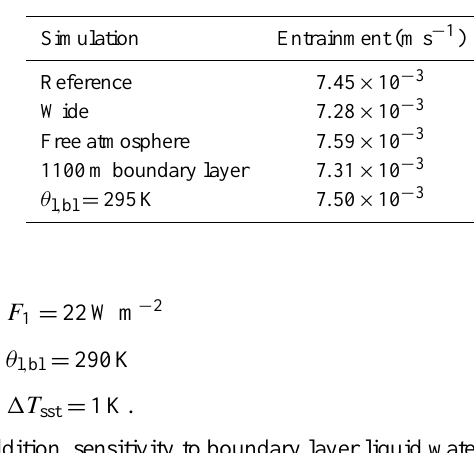
Table 2. The least squares fit of the rate of entrainment for different domain